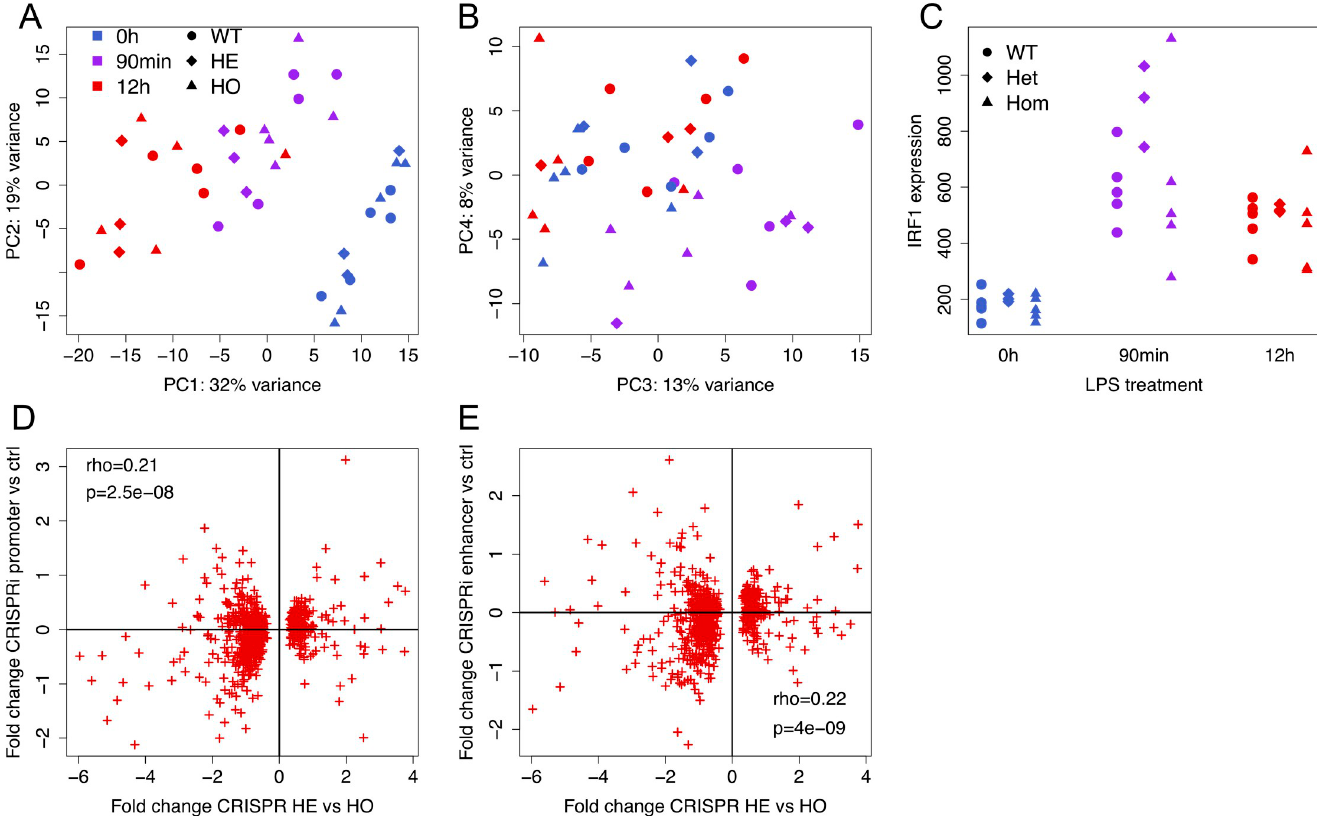
Fig 3. Genome editing with CRISPR. A-B) principal component analysis of gene expression for the different genotypes and LPS conditions, with principal components 1 and 2 in (A) and 3 and 4 in (B); C) IRF1 expression (gene counts normalized to sample read depth) for the different genotypes and conditions; D-E) Correlation of gene expression fold changes at 12h LPS condition for genes that are differentially expressed in heterozygous lines compared to homozygous lines at 0.25 FDR (x-axis), versus expression fold change for promoter (D) and enhancer (E) silencing (y-axis).